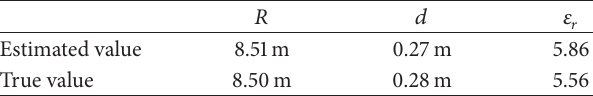
Table 2: Estimation of wall parameters for real